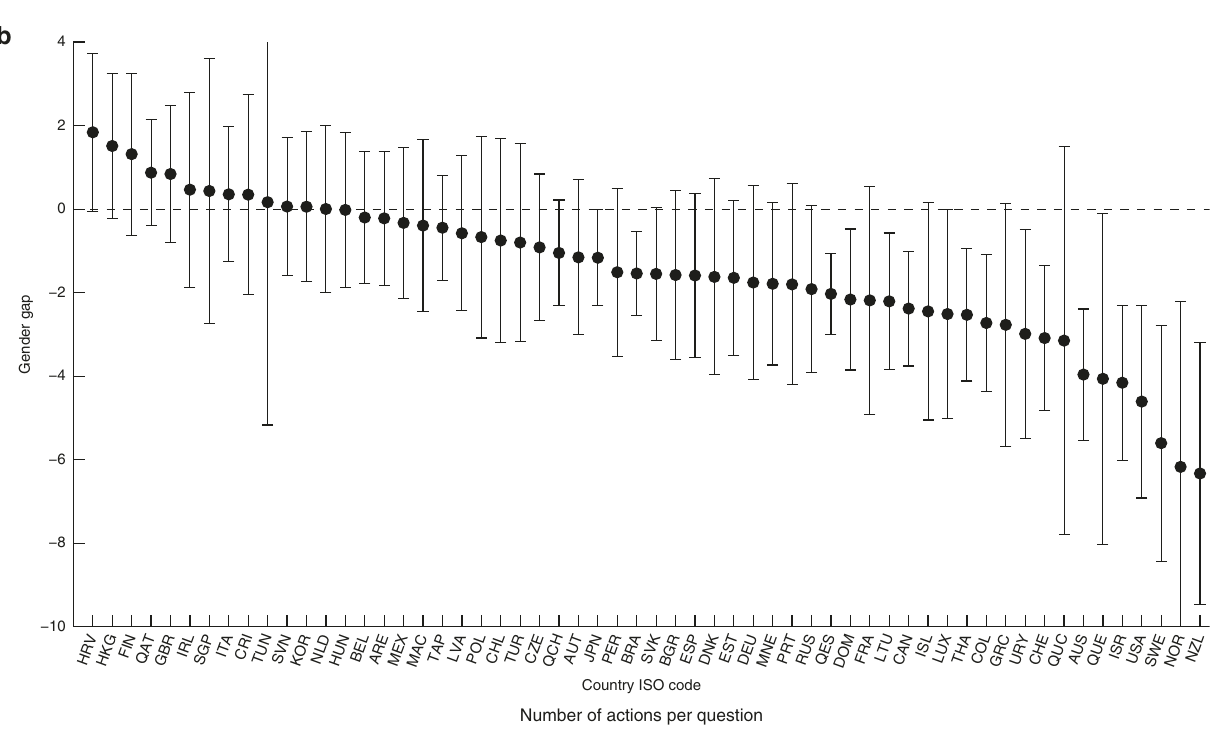
Fig. 4 Gender differences in sustaining time spent per question and number of actions per question. The fi gures plot the estimates of the gender gap in sustaining a time spent per question and b the number of actions per question for each country participating in the PISA 2015. Positive values indicate the gender gap favours females. Error bars represent the 95% con fi dence intervals. Source data are provided as a Source Data fi le (study